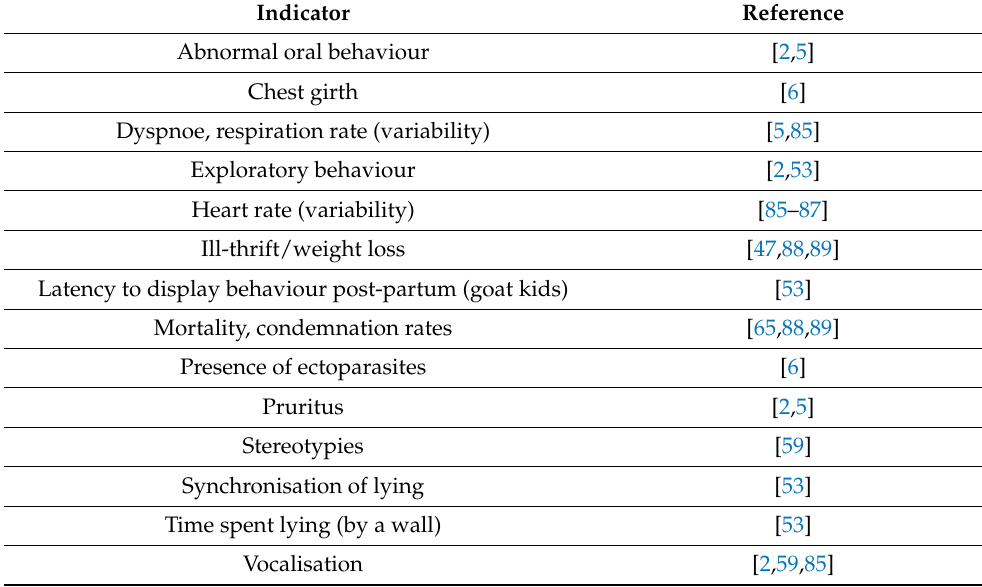
Table 2. Potential welfare indicators for goats that lack on-farm validation and/or have little literature